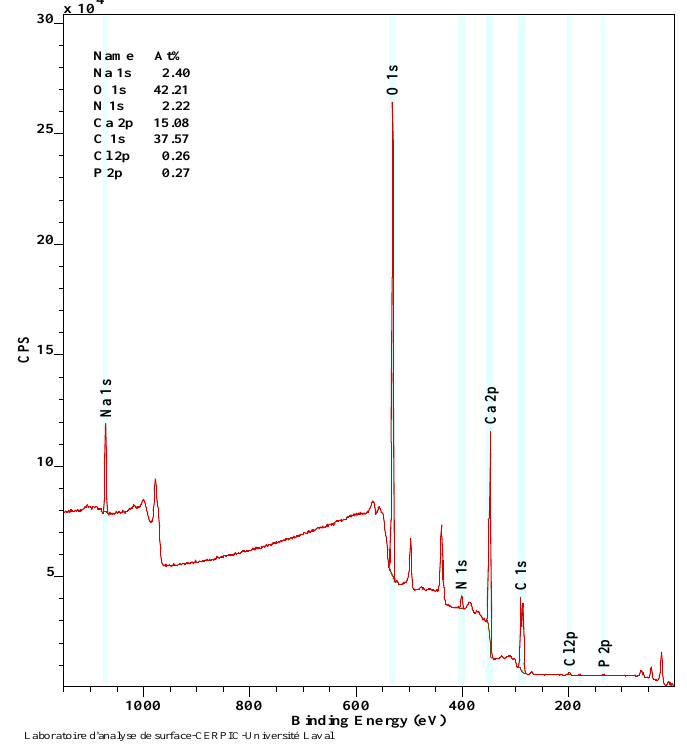
Figure 5. Survey spectrum of elementary analysis on embedded UVAs into CaCO 3 sample.